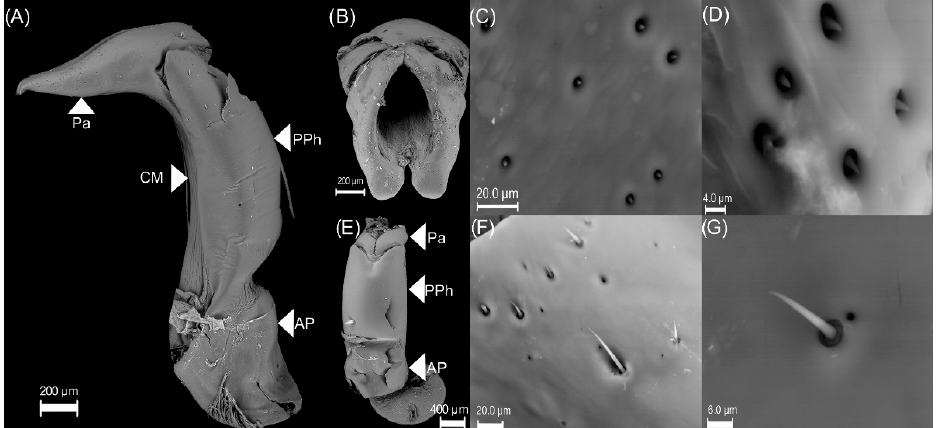
Figure 3. Genital capsule of 18 d old Cyclocephala barrerai male. ( A ) genital capsule (lateral view), ( B ) parameres (frontal view), ( C ) ultrastructure in parameres (distal view), ( D ) ultrastructure in parameres (proximal view), ( E ) genital capsule (dorsal view), ( F ) pits and ultrastructure in phallobase (proximal view), ( G ) pits and ultrastructure in phallobase (posterior view). Pa = parameres, PPh = posterior phallobase, CM = connecting membrane, AP = anterior phallobase.